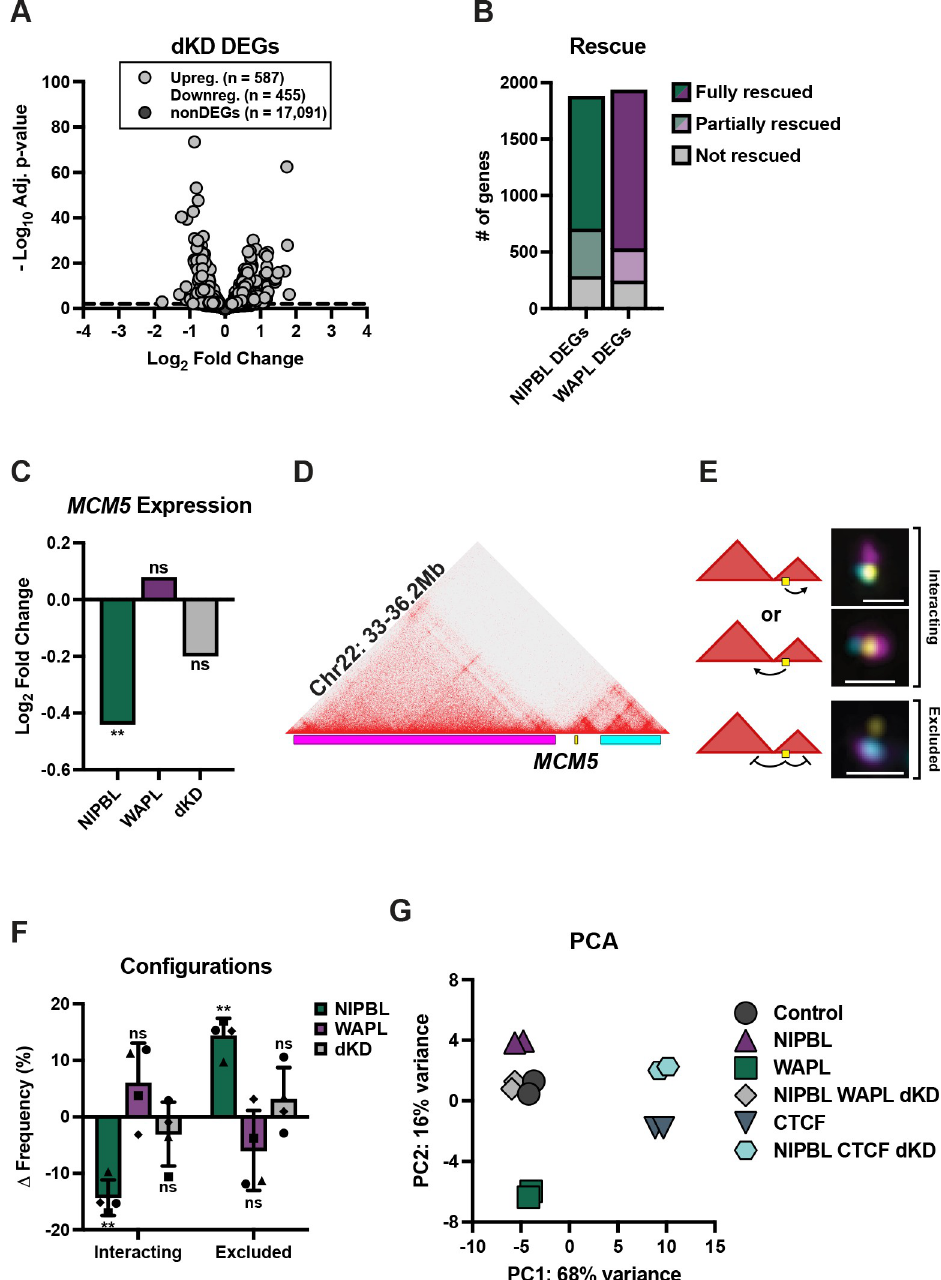
Fig 5. NIPBL and WAPL balance cohesin activity to regulate gene expression. (A) The log 2 (fold change) of genes after NIPBL and WAPL double knockdown versus their significance. DEGs are in light grey (587 up, 455 down) and non-significantly changed genes (adjusted p-value > 0.01) are in dark grey. (B) Number of NIPBL and WAPL DEGs fully, partially, or not rescued in the double knockdown condition. (C) The log 2 (fold change) of MCM5 expression in the NIPBL, WAPL, or double knockdown conditions. �� p = 0.002, ns = not significant (p = 0.58 for WAPL, p = 0.13 for dKD). (D) Oligopaint design to MCM5 and neighboring domains at chr22:32–36.2Mb. (E) Cartoon diagrams and representative FISH images of the possible interactions between MCM5 and its neighboring domains at chr22:32– 36.2Mb. The “interacting” configuration is defined as the majority of the MCM5 signal overlapping either the up or downstream domain. “Exclusion” is defined as the majority of MCM5 signal non-overlapping with either neighboring domain. Dashed line represents nuclear edge, scale bar 1 μ m. (F) Change in the frequency of interacting and exclusion between MCM5 and neighboring domains at chr22:32–36.2Mb in RNAi control, NIPBL, WAPL, or double knockdown cells. Each bar represents the mean of four biological replicates, error bars represent standard